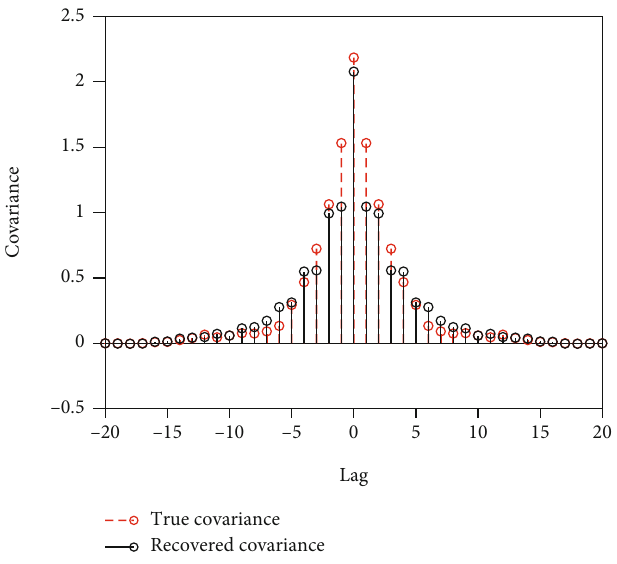
Figure 9: True and recovered covariance for the length-21 AR signal with M / N = 11/21 and SNR = 30dB